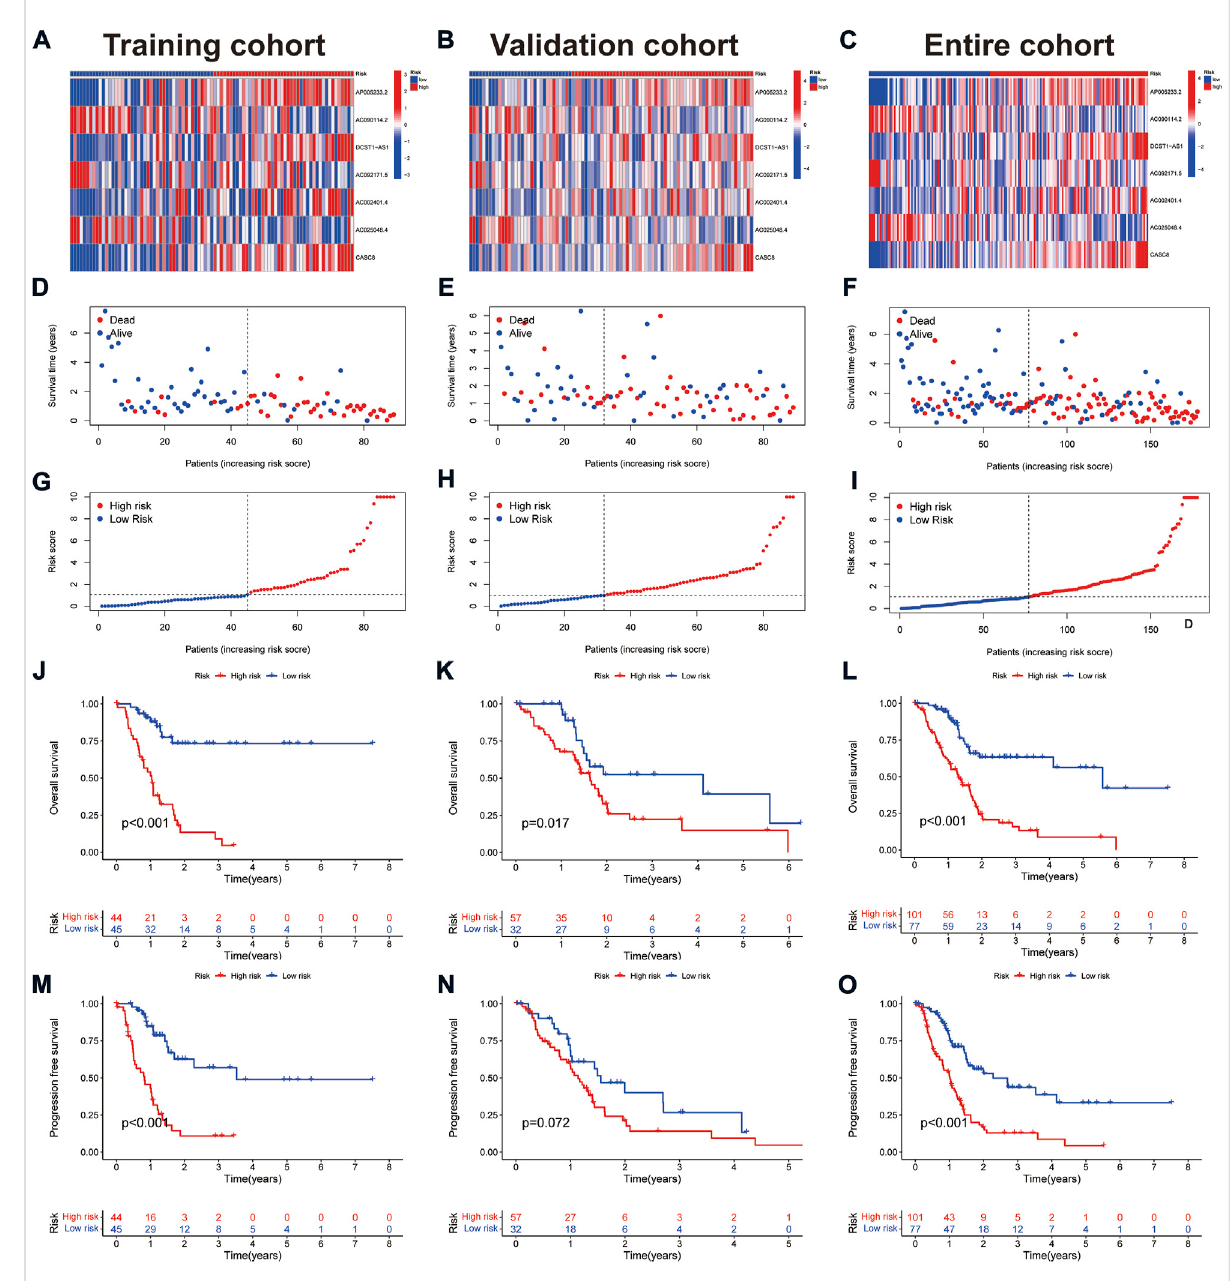
FIGURE 3 Prognostic values of the CAFs-associated lncRNAs signature. (A – C) Heat map showing expression levels of the seven lncRNAs in the training, validation, and entirecohorts. (D – F) Survivaltimeandstatus inthetraining,validation, andentirecohorts. (G – I) Riskscore distribution inthetraining, validation,andentirecohorts. (J – L) Kaplan-MeiercurveforOSinthetraining,validation,andentirecohorts. (M – O) Kaplan-MeiercurveforPFSinthe training, validation, and entire